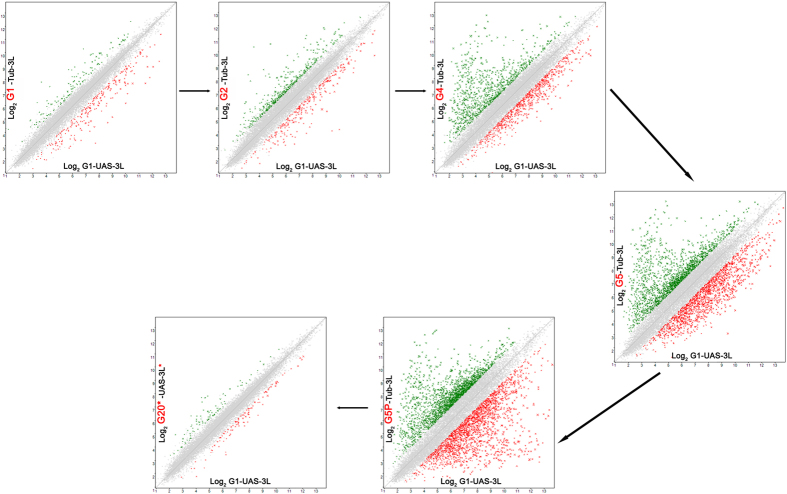
Misregulation of gene expression in flies expressing DNMT3L is gradual and progressive.(A–F) Scatter plots showing the upregulated and downregulated genes in each generation of the DNMT3L expressing transgenic flies. Comparison was made between gene expression levels in 3rd instar Tub-3L larvae from a particular generation (indicated on the Y Axis) with UAS-3L control larvae from G1. Note a progressive increase in the number of genes that were aberrantly expressed in successive generations. Green crosses represent upregulated genes while red crosses represent down regulated genes. Number of genes misregulated was minimal in G20 flies that lacked DNMT3L expression due to the removal of the GAL4 driver. G1, G2, G4, G5, denotes Tub-3L larvae from the particular generation. G5P denotes 5th generation Tub-3L larvae with melanotic tumors. G20*-UAS-3L*- denotes G20 flies after removal of the GAL4 driver by crossing flies with double balancers.